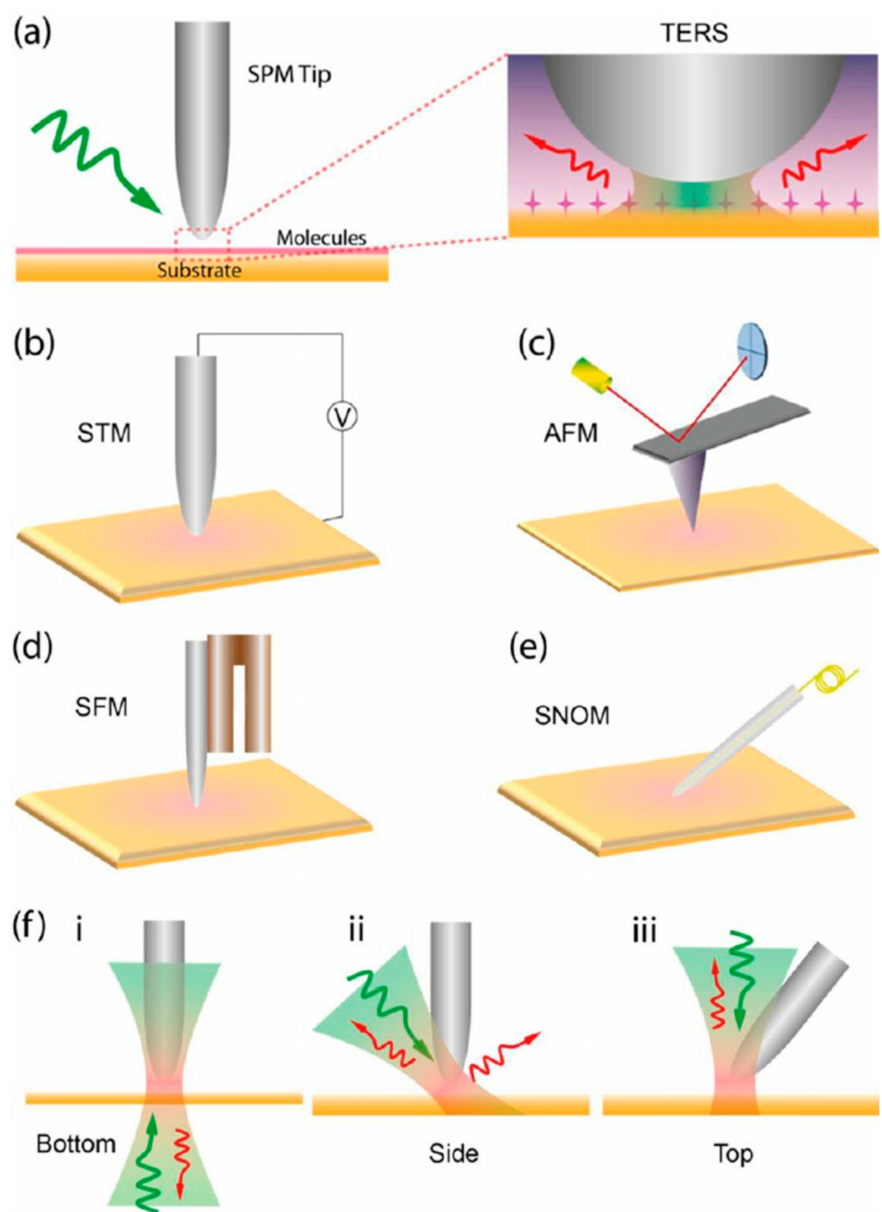
Figure 1. ( a ) Diagram of TERS, and corresponding SPM technology as ( b ) STM ( c ) AFM ( d ) SFM and ( e ) SNOM. ( f ) Three different kinds of excitation and collection: ( i ) Side excitation and side collection, ( ii ) bottom excitation and bottom collection and ( iii ) top excitation and top collection